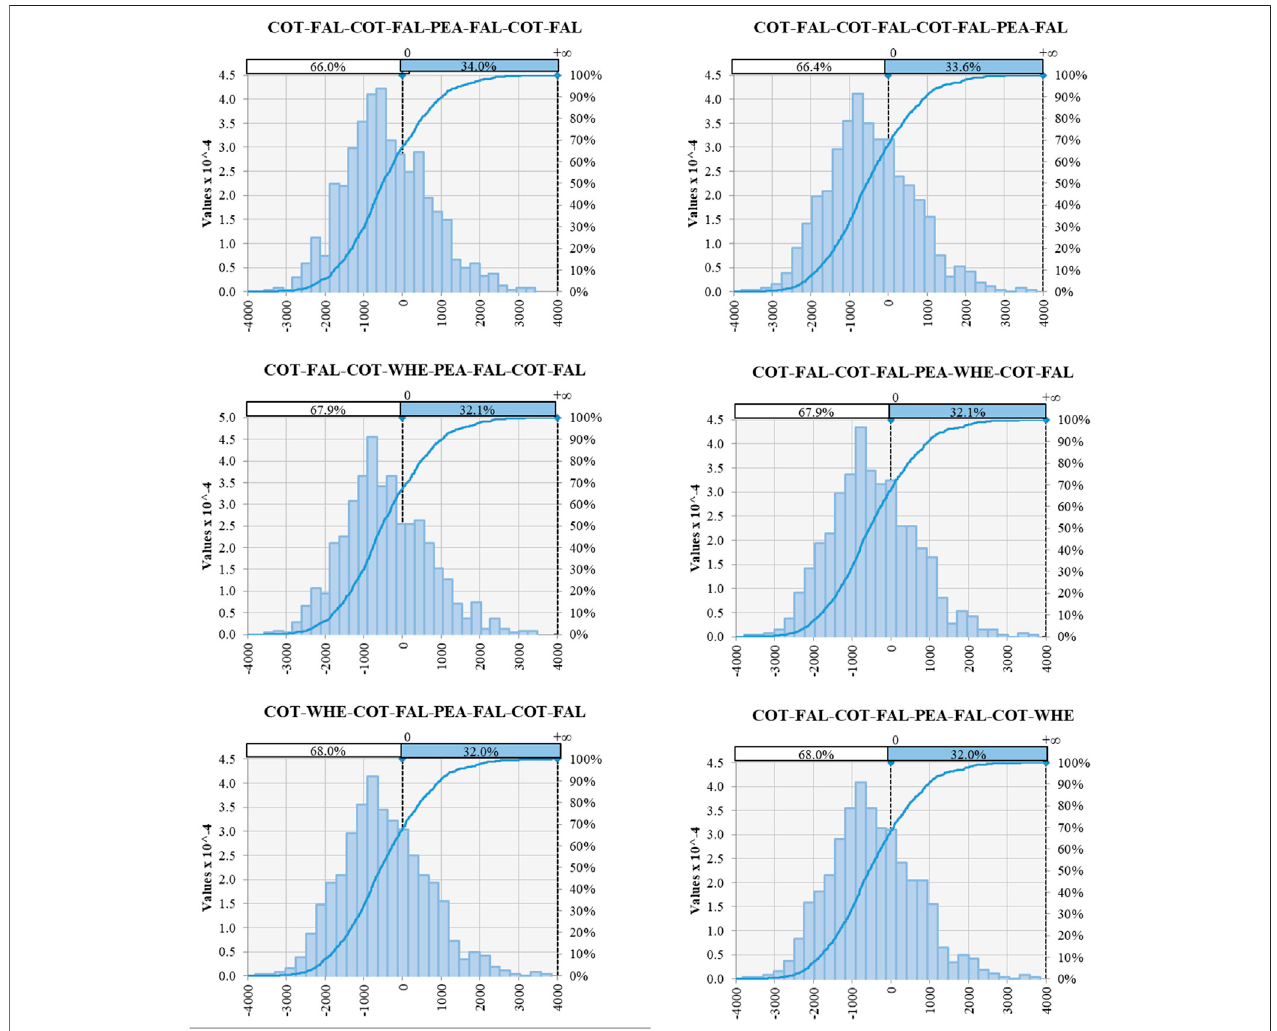
FIGURE 5 | Relative distribution and cumulative frequency of top-six rotations under S1 with the highest chance of positive NPVs.